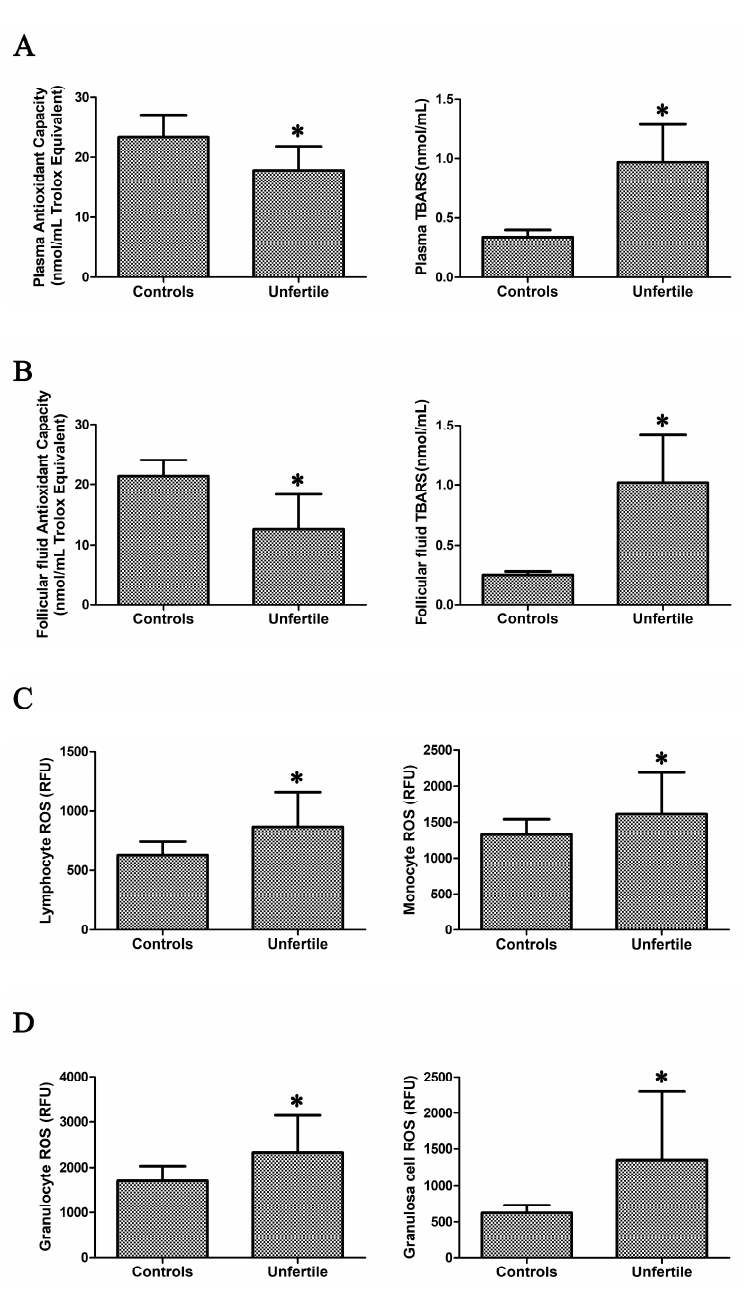
Figure 1. Oxidative stress parameters in the plasma and follicular fluid of infertile patients and controls. Total antioxidant capacity and lipid peroxidation in plasma ( A ) and follicular fluid ( B ), leukocyte and granulosa cells reactive oxygen species (ROS) production ( C , D ) in infertile patients ( n = 45) and controls ( n = 45). * indicates that differences are statistically significant at the p < 0.05 level.